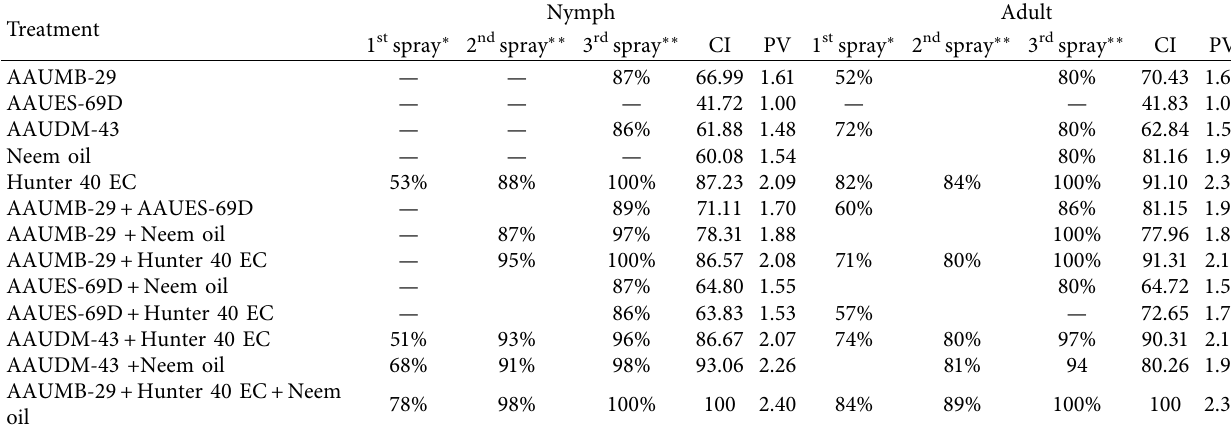
Table 4: The effects of single and combined application of biopesticides in the reduction of nymph and adults (%) of whitefly T. vaporariorum on the Melkashola tomato